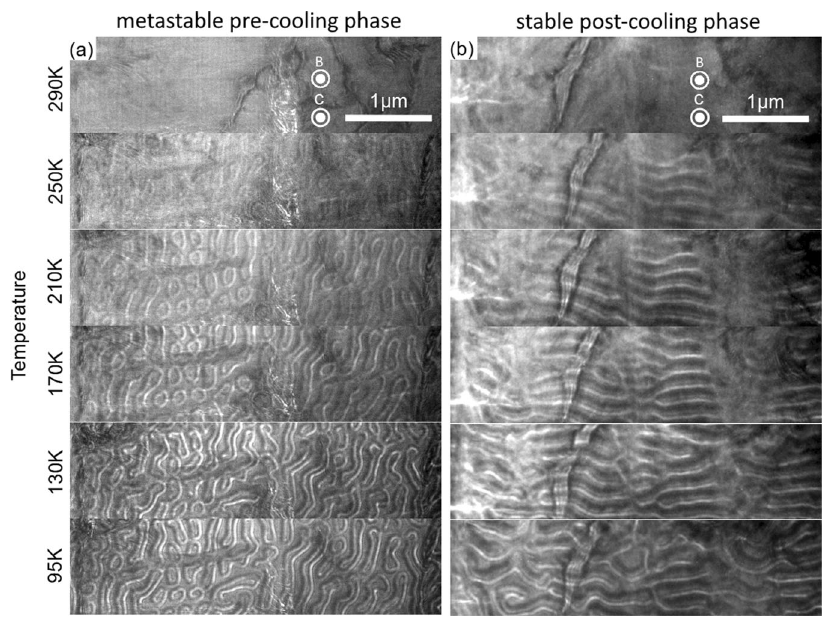
Fig. 5 Fresnel images of Fe 5 GeTe 2 at various temperatures. The temperature is indicated in the fi gure and a constant external fi eld of B = 100 mT is applied. A defocus of − 1 mm was used in a plan-view lamella (c-axis is perpendicular to the image plane), recorded before a and after b leaving the sample in liquid nitrogen for one